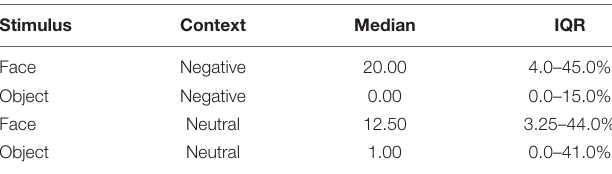
TABLE 1 | Median and interquartile range (IQR) of faces and objects rated as negative in each context. Stimulus